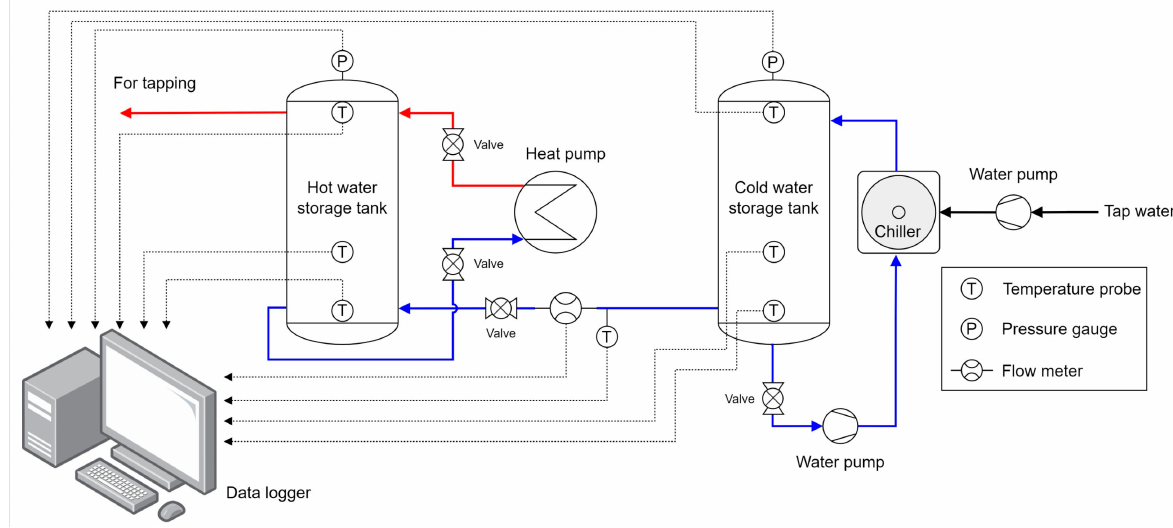
Figure 6. Schematic diagram of the experiment.